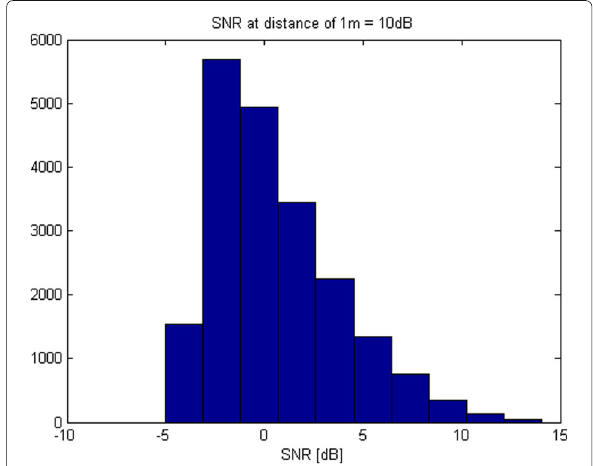
Fig. 12 Distribution of SNRs at the antennas for simulated Tx locations for SNR 0 = 10 dB